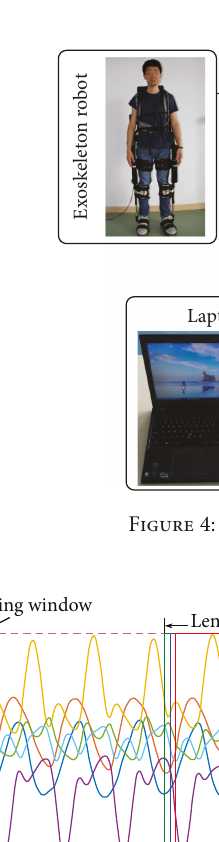
Figure 6: The basic architecture of an LSTM memory block with one memory